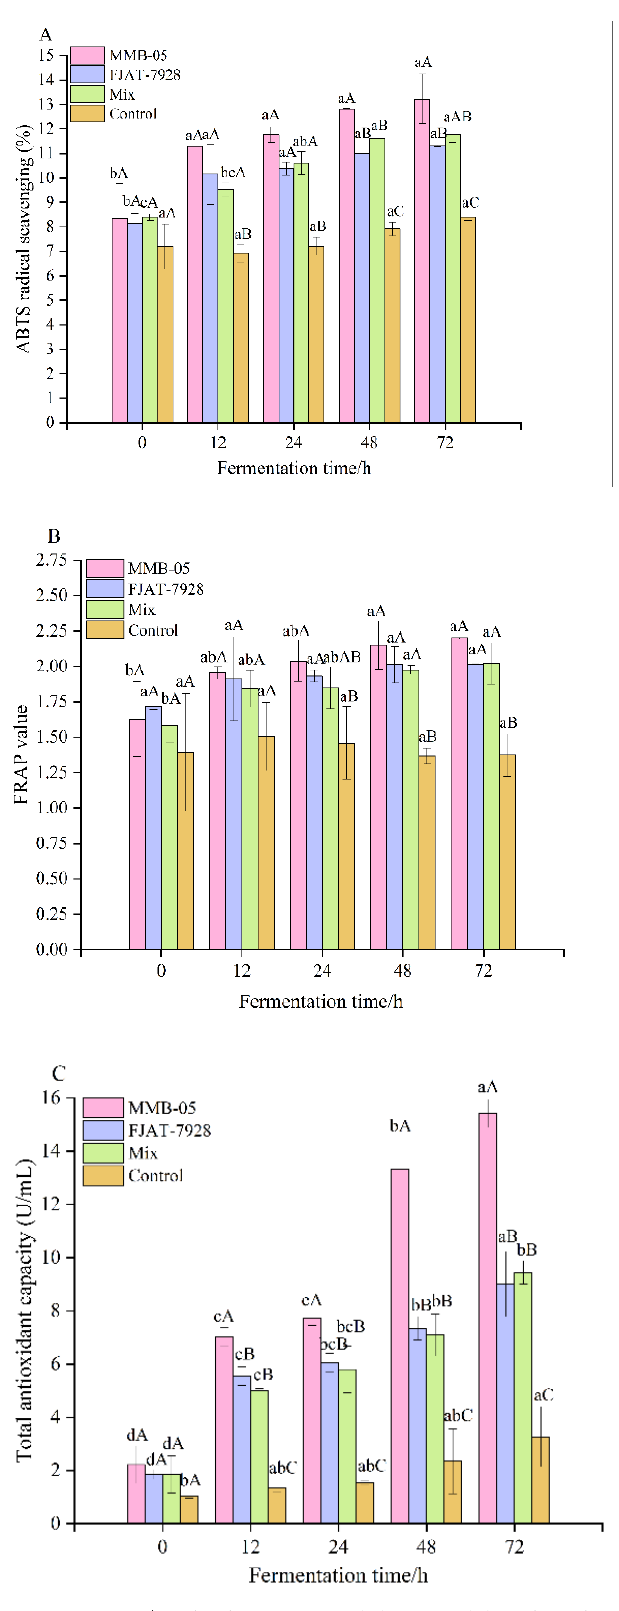
Figure 7. ABTS + radical scavenging ( A ), FRAP ( B ) and total antioxidant capacity ( C ), in P. yezoensis sauce fermented by LAB stains. Note: abcd represents the significant difference between groups (different fermentation time in the same group). ABC represents the significant difference between the same fermentation time of different groups ( p < 0.05).